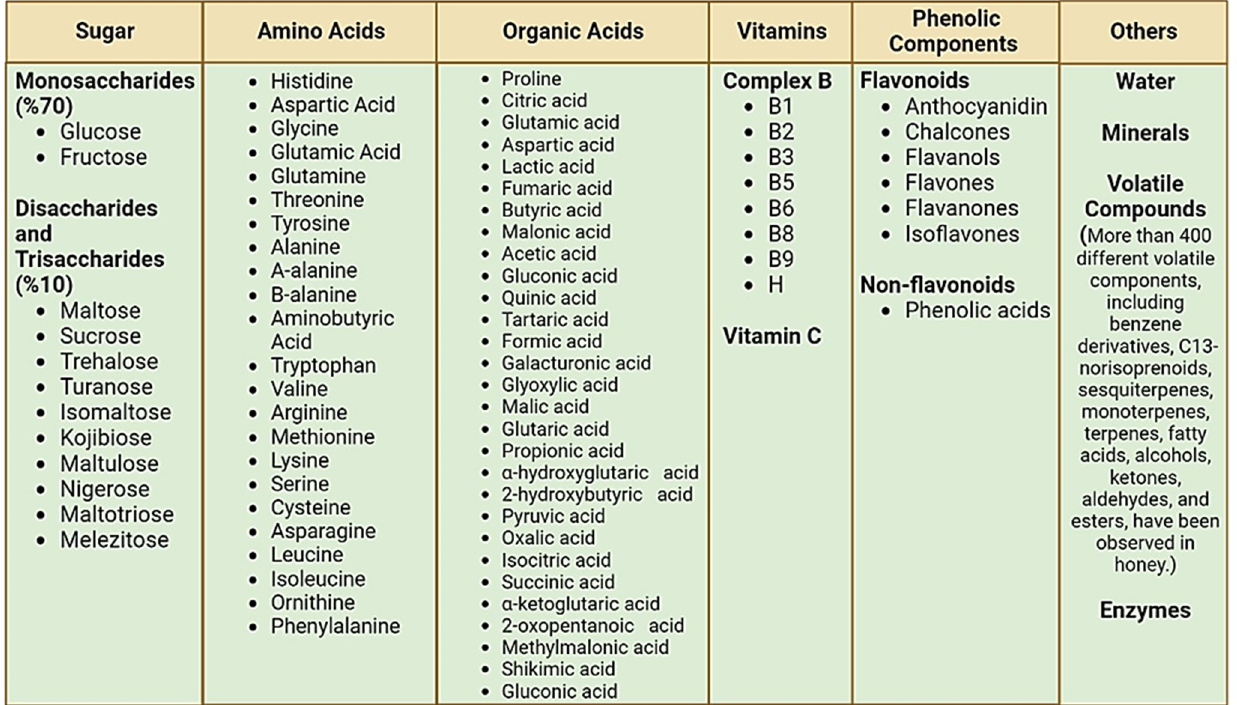
Figure 2. General composition of honey.